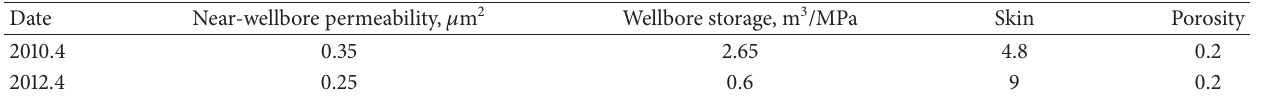
Table 6: Interpreted parameters.